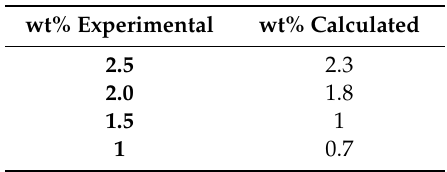
Table 1. Comparison of the experiment cellulose concentrations (wt%) vs. those calculated from fitting the SAXS measurements